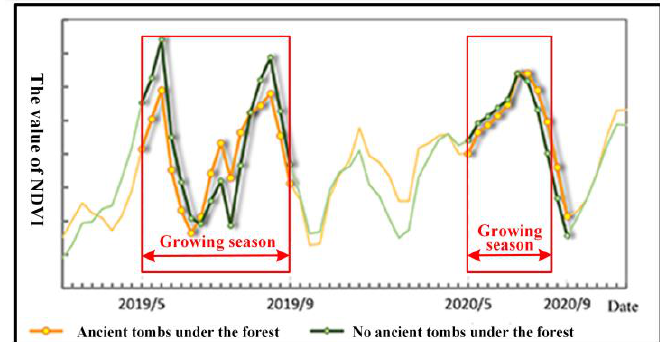
Figure 9. Timing-series features of NDVI.